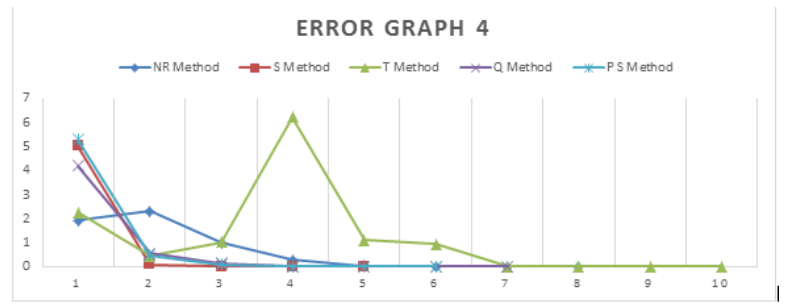
Figure 4. Graphical comparison of error analysis for the Equation